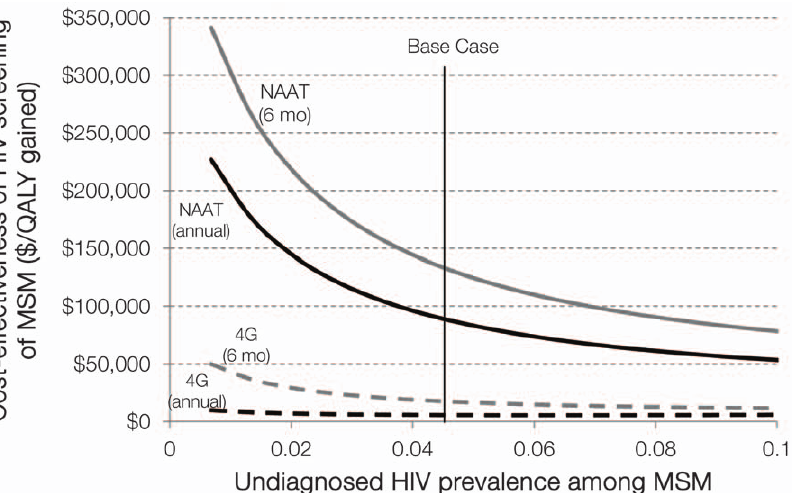
Figure 4. One-way sensitivity analysis on undiagnosed HIV prevalence among MSM. The cost-effectiveness of NAAT (solid line) or fourth- generation immunoassay (dashed line) testing of MSM, given variations in undiagnosed HIV prevalence among MSM. Testing occurs annually (black line) or every six months (grey line), and cost-effectiveness of NAAT is relative to screening with fourth-generation immunoassay only. MSM = men who have sex with men; NAAT = nucleic acid amplification test; 4G = fourth-generation immunoassay; QALY = quality-adjusted life year.